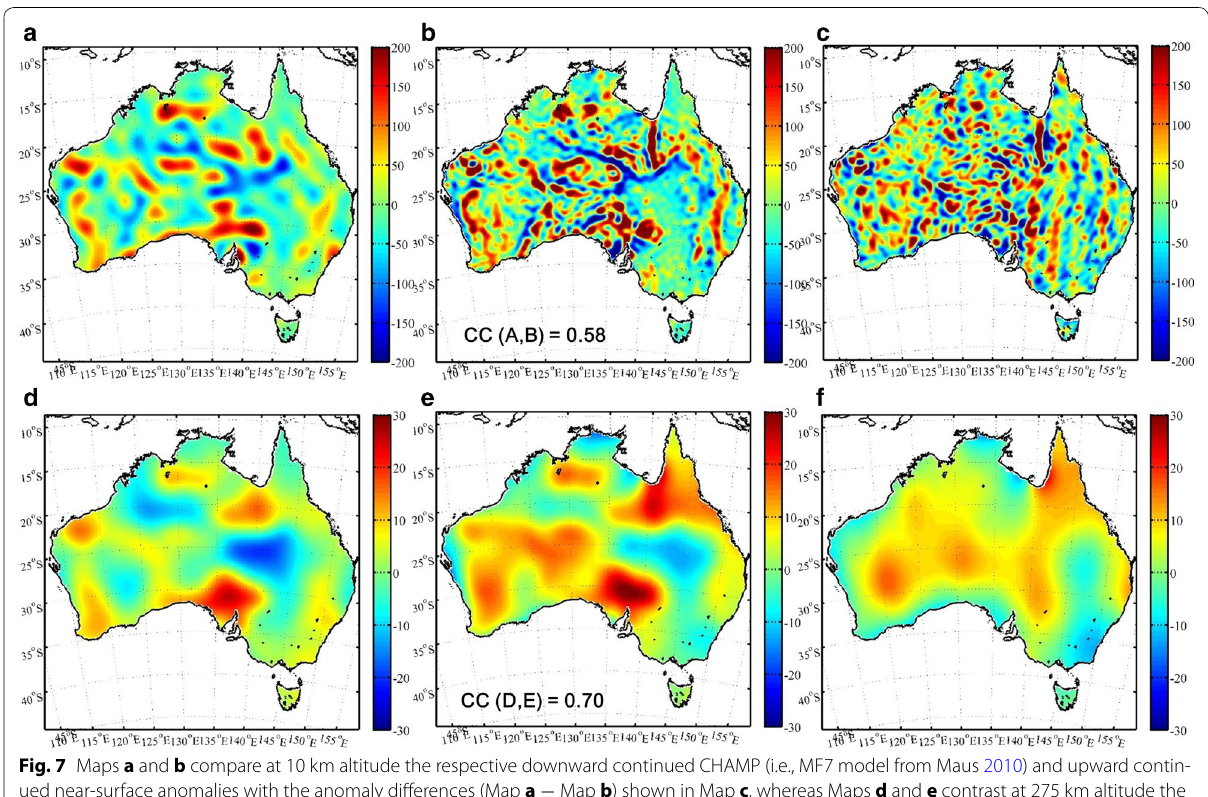
Fig. 7 Maps a and b compare at 10 km altitude the respective downward continued CHAMP (i.e., MF7 model from Maus 2010) and upward contin- ued near-surface anomalies with the anomaly differences (Map a Map b ) shown in Map c , whereas Maps d and e contrast at 275 km altitude the − respective downward continued CHAMP and upward continued near-surface anomalies with the anomaly differences (Map d Map e ) given in − Map f . Included on maps b and e are the respective correlation coefficients between maps a and b , and maps e and